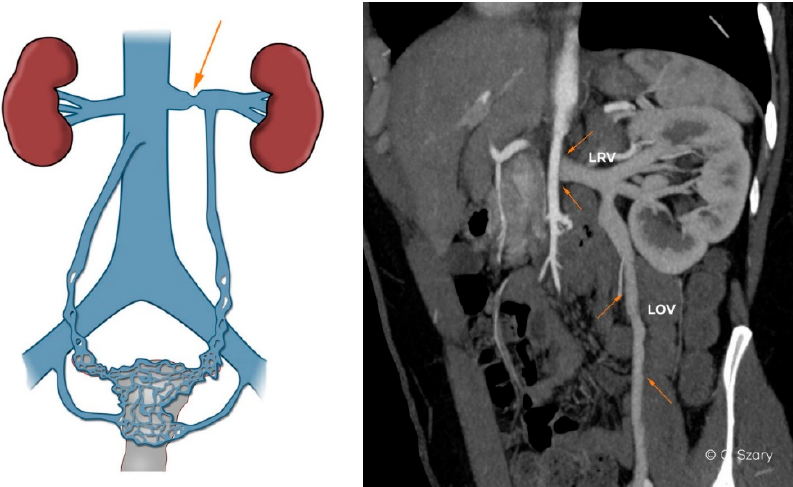
Figure 5. Typical anatomy of nutcracker syndrome. Insufficiency of LOV on computed tomographic venography (CTV) image.